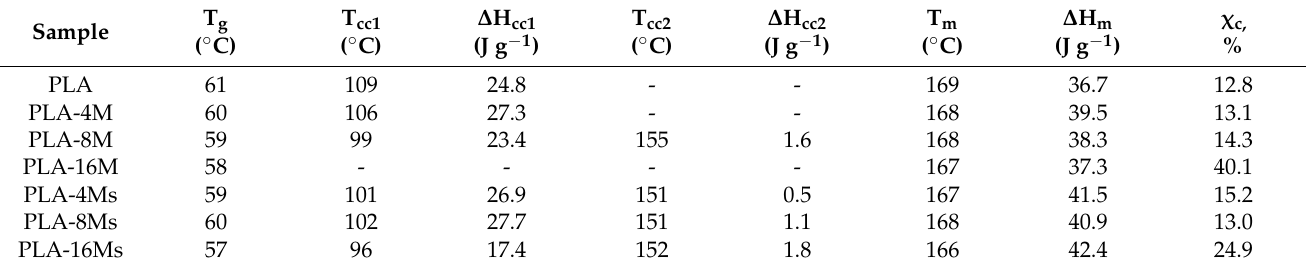
Table 3. Comparative DSC data of PLA and PLA-magnetite nanocomposites (second DSC heating, 10 °C/min). T g Sample